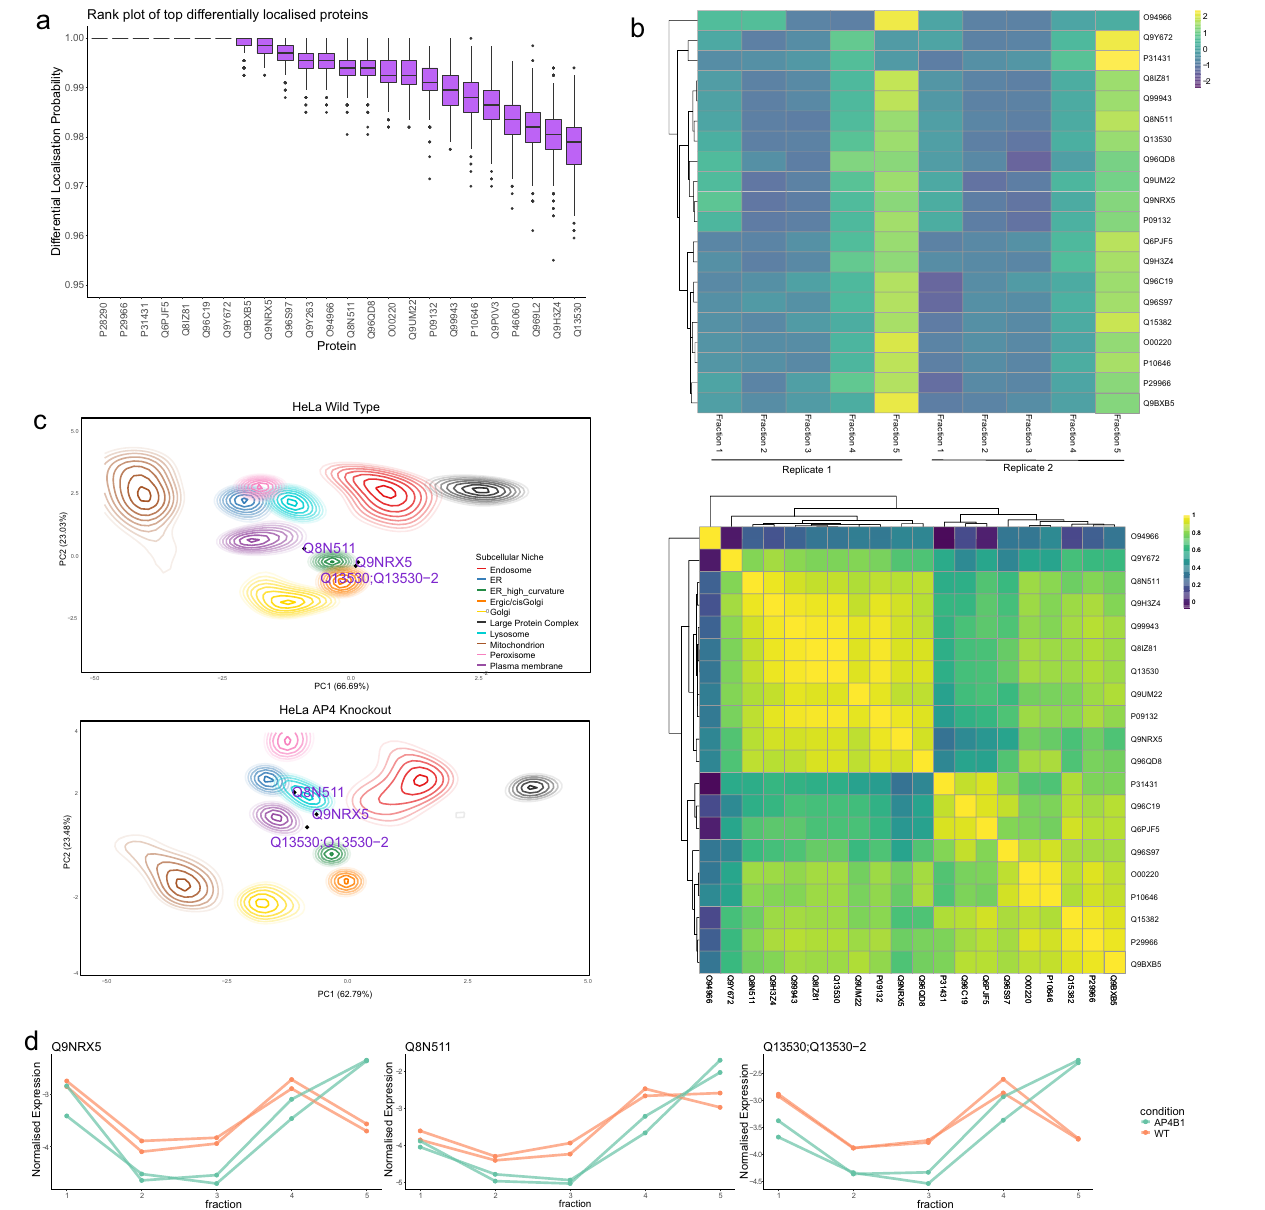
Fig. 5 | BANDLE applied to the AP-4 dataset. a The top differentially localised proteins from BANDLE plotted with uncertainty estimates. Data are presented as medians with notches representing the interquartile range (IQR), and the whiskers extending to 1.5*IQR. 667 MCMC samples were used. b A Spearman correlation heatmap showing strong correlation behaviours of proteins that have AP-4 dependentlocalisation(lower).Normalisedmass-spectrometrypro fi lesplottedasa heatmap from the AP-4 knockout data. Proteins are shown to have similar beha- viourwithgreaterintensityinfraction5,wherelightmembraneorganellesarelikely